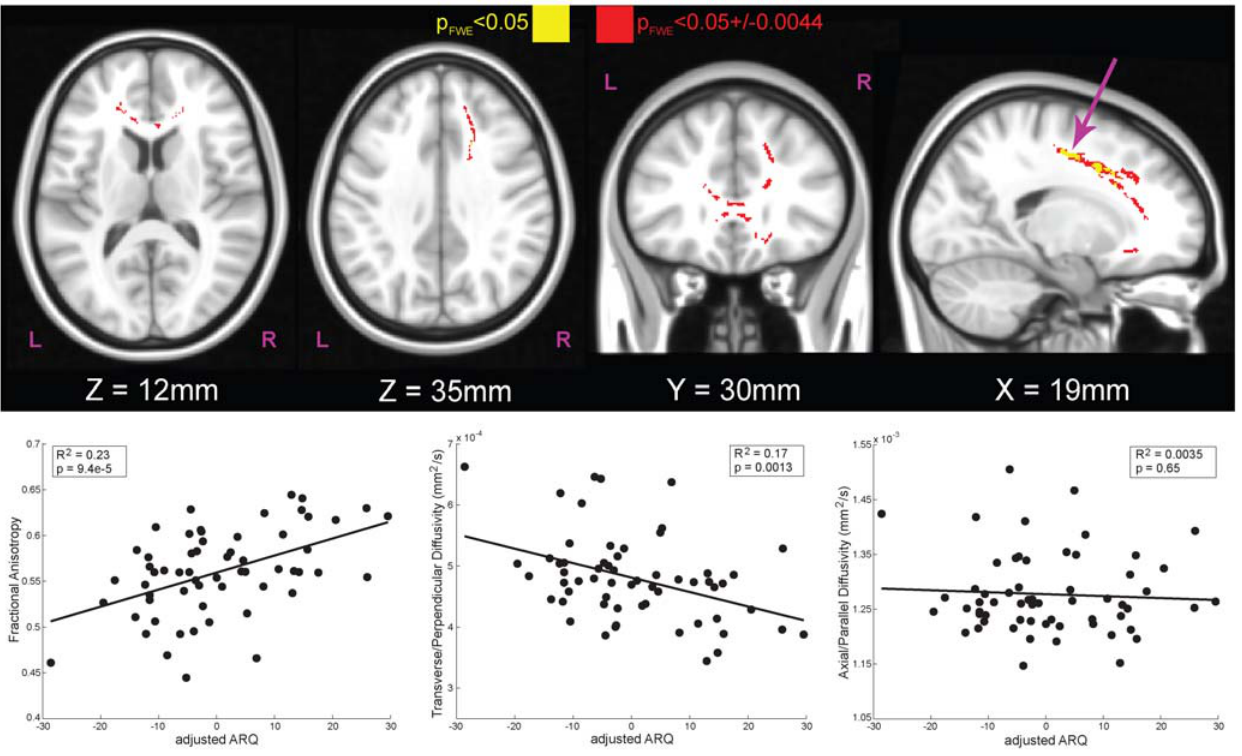
Figure 3. White matter tracts with significant correlations of DTI components to adjusted-ARQ in adolescents 14 years and older (N=60). The effect of age and sex was first removed from ARQ (Fig. 1), yielding a score that captures engagement in dangerous behaviors independent of sex and chronological age. Using the map for fractional anisotropy (FA), we used tract-based spatial statistics to identify regions within skeletonized white matter tracts that were significantly correlated with adjusted-ARQ. Main effects for sex and age were also included in the DTI model so that the regions identified as being correlated with adjusted-ARQ were purely ARQ-related. The maps were fully-corrected for familywise error (FWE) and thresholded at P , 0.05 ( yellow ). Because significance was determined using a permutation test based on 10,000 samplings of the dataset, the exact level of significance had a margin of error. The 95% confidence interval on this statistic ( 6 0.0044) is also shown ( red ). The scatter plots illustrate the relationship between adjusted-ARQ and component DTI measures for the right superior corona radiata ( arrow ), but the pattern was the same for all significant regions. Increased ARQ was associated with increased fractional anisotropy (FA, left bottom ), which was due primarily to a decrease in TD ( middle bottom ). These results show that adolescents who engage in dangerous activities have more mature frontal white matter tracts relative to their conservative peers.